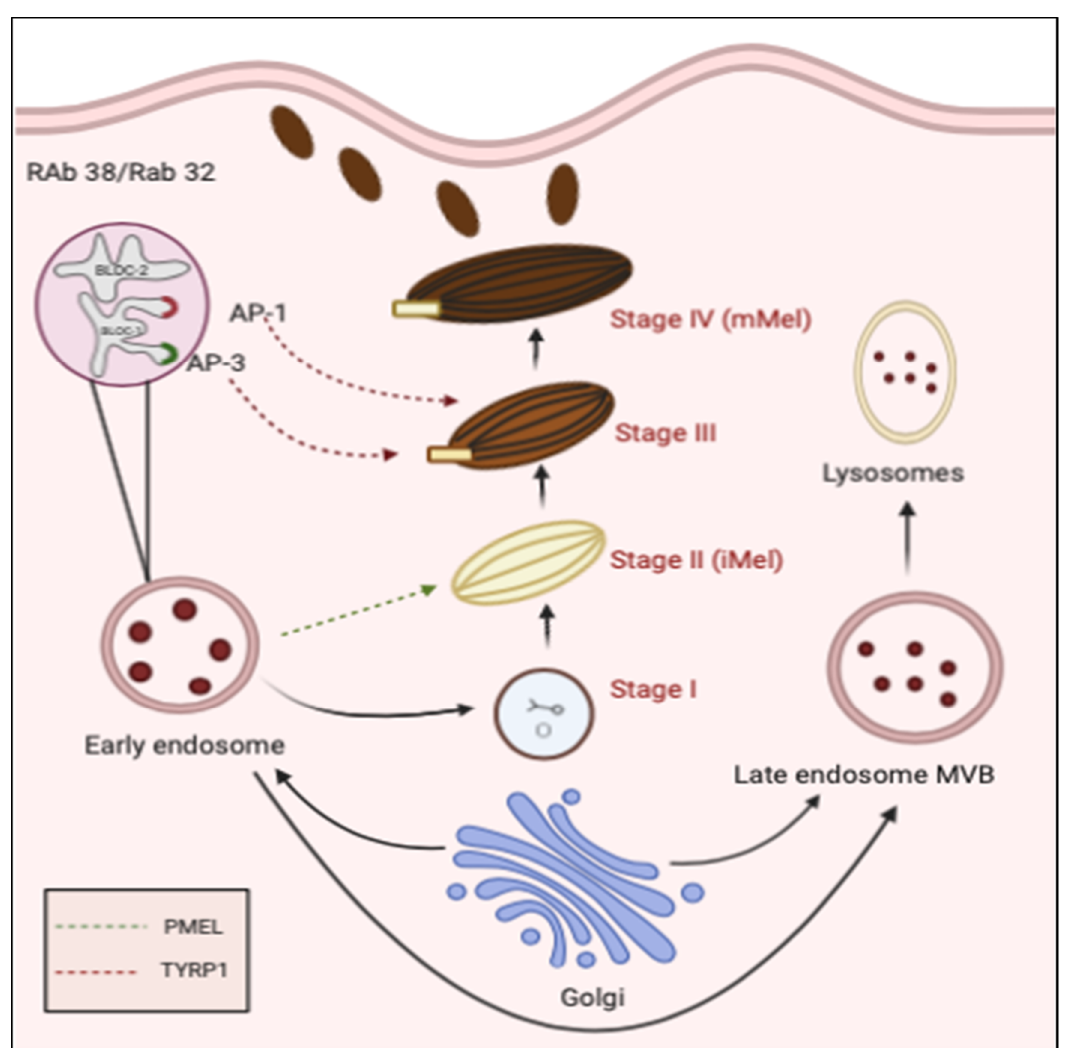
Figure 3. Schematic representation of melanosome biogenesis in melanocytes. Immature melanosomes stage I is derived from early endosomes. Stage II (immature melanosomes—iMel) is formation of non-pigmented melanosomes containing PMEL fibrils (indicated in green dotted lines). At stage III, melanogenesis begins with translocation of tyrosinase related proteins (TYR—indicated in red dotted lines) from tubular elements of early endosomes. Stage IV marks the maturation of melanosomes (mMel) facilitating melanin deposition. Adaptor protein-3 (AP-3) and Adaptor protein-1 (AP-1) are adaptors for sorting TYR to melanosomes. BLOC-1 and BLOC-2 are regulators of endosome-to-melanosome transport. Rab32/38 are tissue specific proteins which play essential roles in pigmentation.